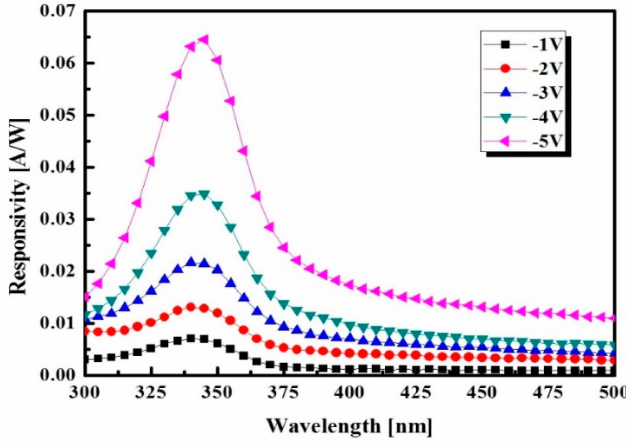
Figure 9. Spectral response of optimized UV photodetector as increased reverse bias.